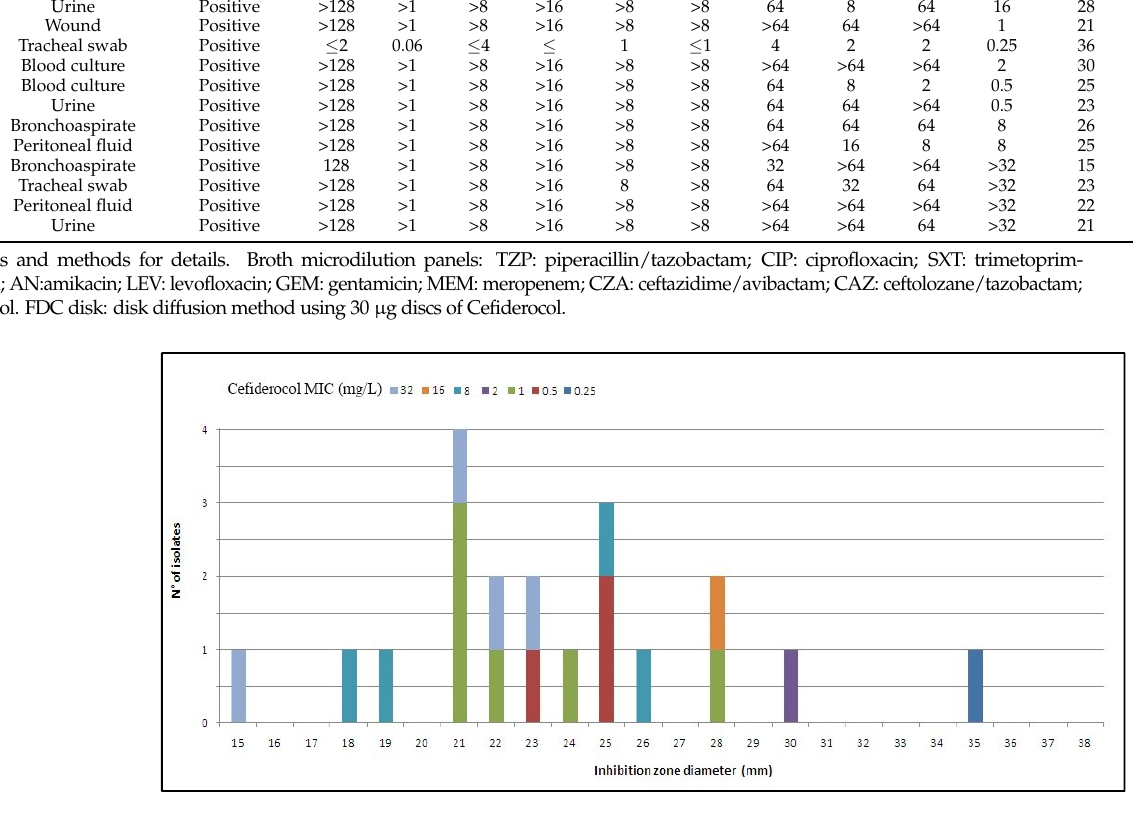
Figure 1. Cefiderocol 30 µg vs. MIC Acinetobacter baumannii , 20 isolates (EUCAST